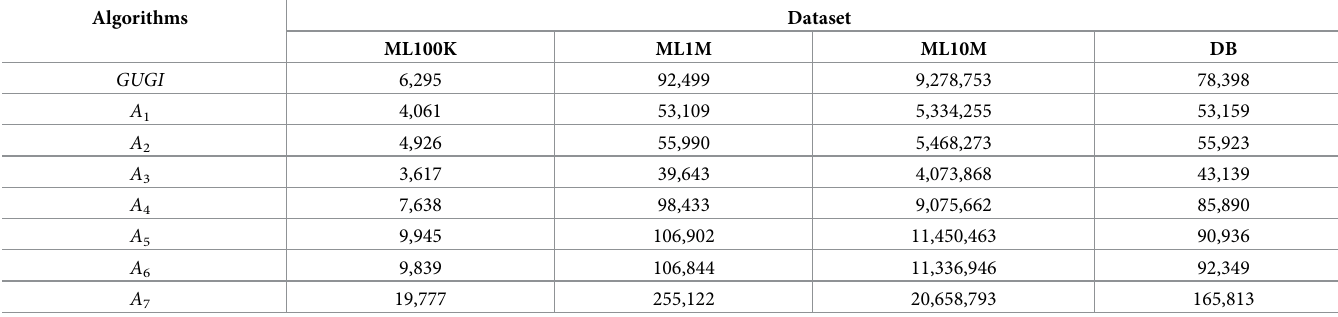
Table 4. Runtime comparison under M-distance clustering (unit: